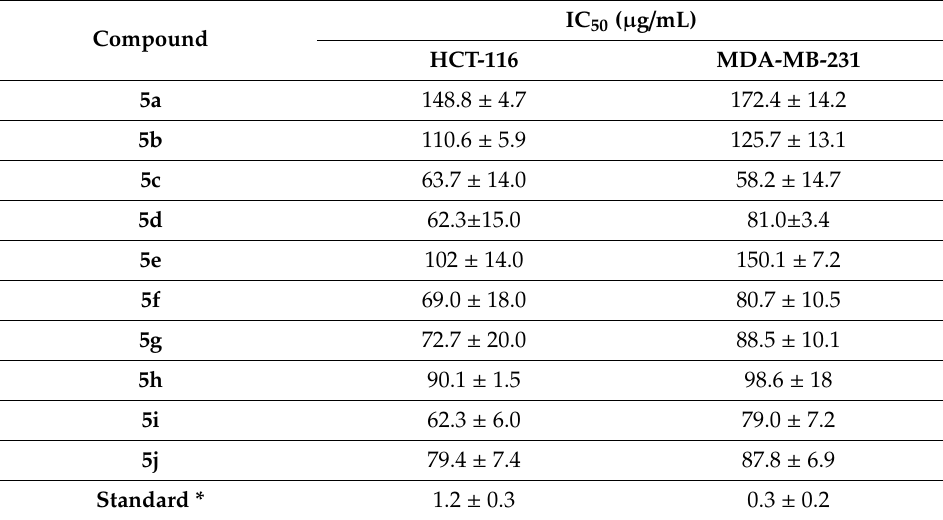
Table 4. Anticancer activity of compounds 5a–5j.